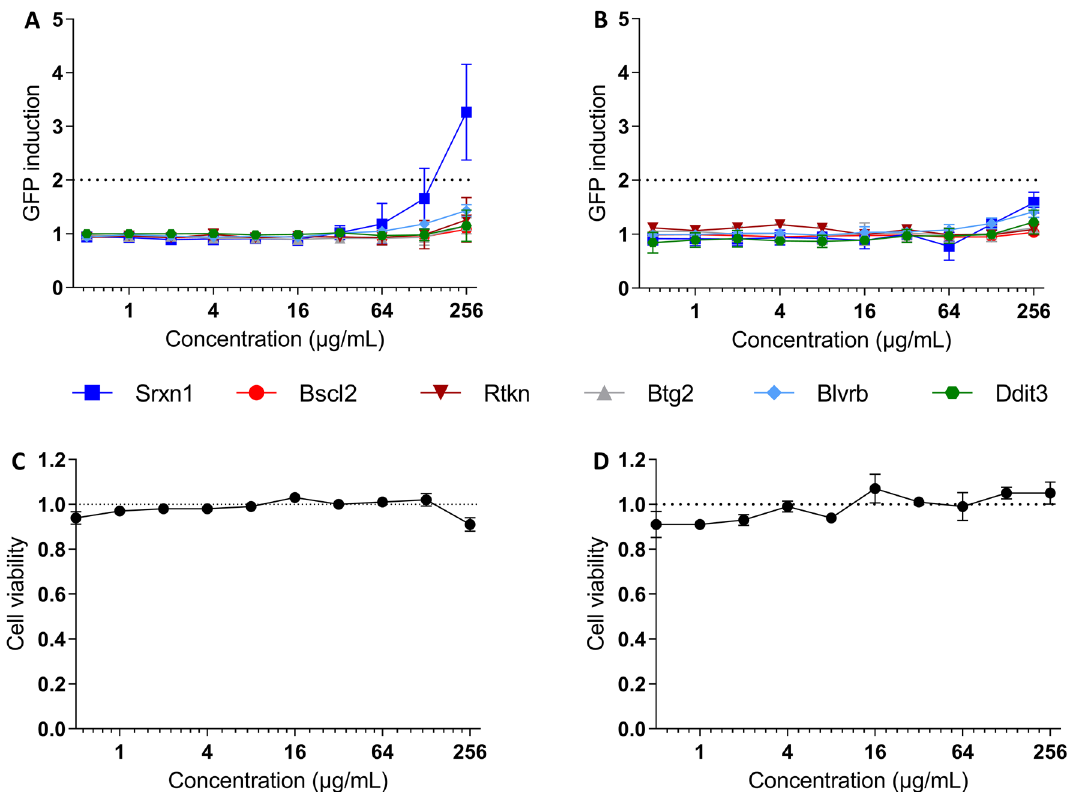
Figure 5. Activation of ToxTracker reporter cells following exposure to welding particles. Six ToxTracker GFP reporter cell lines were used for evaluation of DNA damage ( Bscl2 and Rtkn ) , p53 activation ( Btg2 ), induction of oxidative stress ( Srxn1 and Blvrb ) and protein damage ( Ddit3 ). Activation of the reporter cells was assessed by flow cytometry after 24 h of exposure to ( A ) stainless steel or ( B ) mild steel particles (0.5–256 µg/mL). Cell viability was simultaneously measured based on scatter parameters for ( C , stainless steel; D , mild steel). All x-axes are logarithmic (log2). The results are presented as mean ± standard deviation of three independent experiments. Figure created using GraphPad Prism version